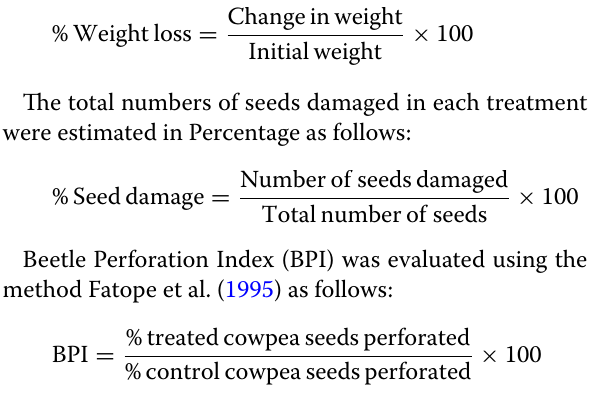
Table 1 Quantitative analysis of phytochemicals (mg/g)